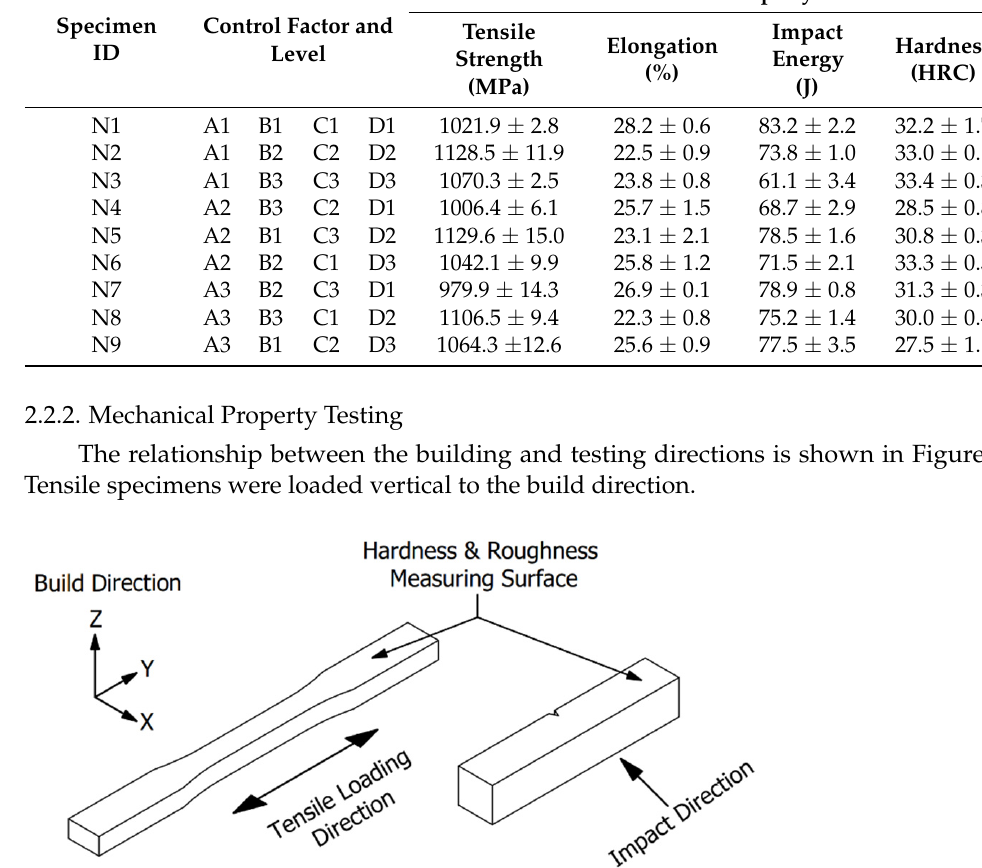
Table 2. Orthogonal array L9 (3 4 ) and mechanical properties of each trial.